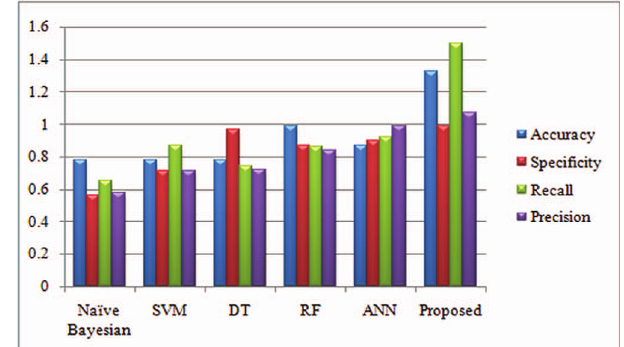
Fig. 19. Analysis comparison of proposed using existing system for 150 trials.